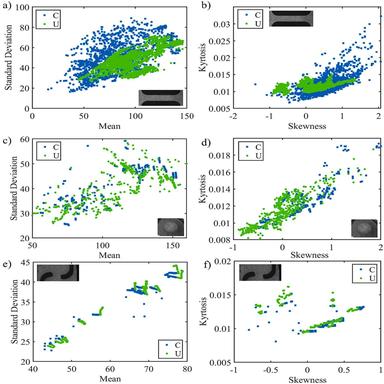
Mean and standard deviation of the cracked (C) and uncracked (U) uniaxial tension large and small size images (a), punch (c), and shear images (e). The corresponding kurtosis and skewness higher-order statistics are provided for each case in (b), (d) and (f).